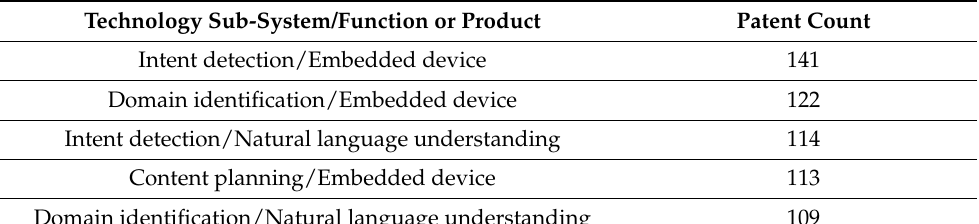
Table 1. Top five patent technology trends of Chatbot dialog